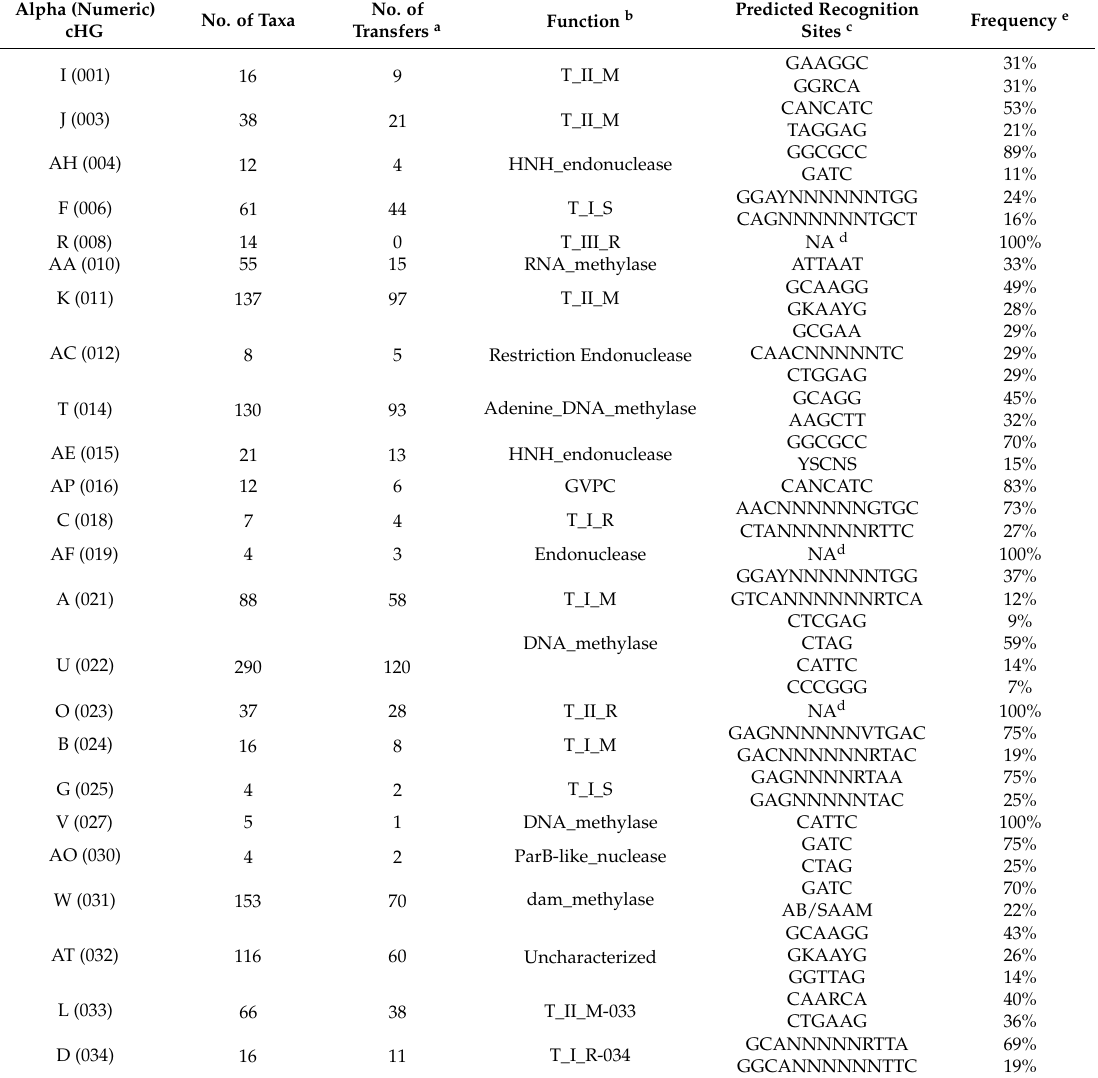
Table 2. Important traits of cHGs with four or more open reading frames